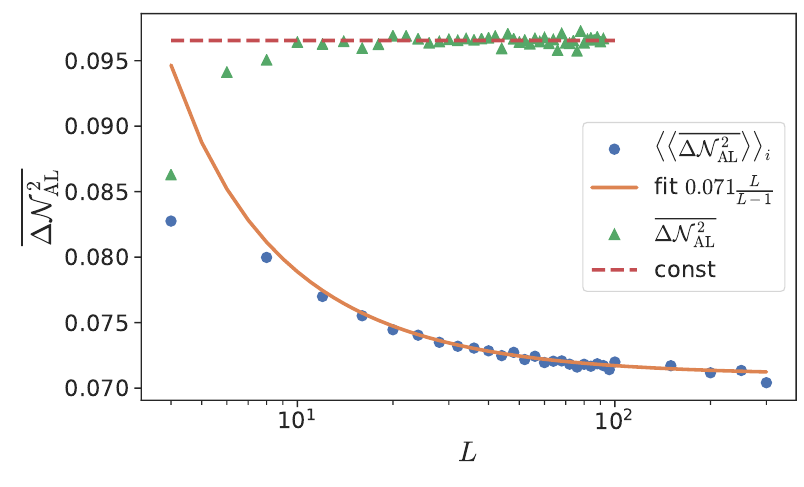
Figure 11: Particle fluctuations in a partition for the Anderson model for an initial density-wave state ∆ N 2 (green triangles) and when averaged over all initial states 〈〈 ∆ N 2 〉〉 (blue dots). To perform the initial state average we used Eq. (30). The i data has been averaged over 50000 disorder realization for L ≤ 100 and 10000 for L > 100. For the calculation of ∆ N 2 starting from a charge density wave common free fermion methods have been